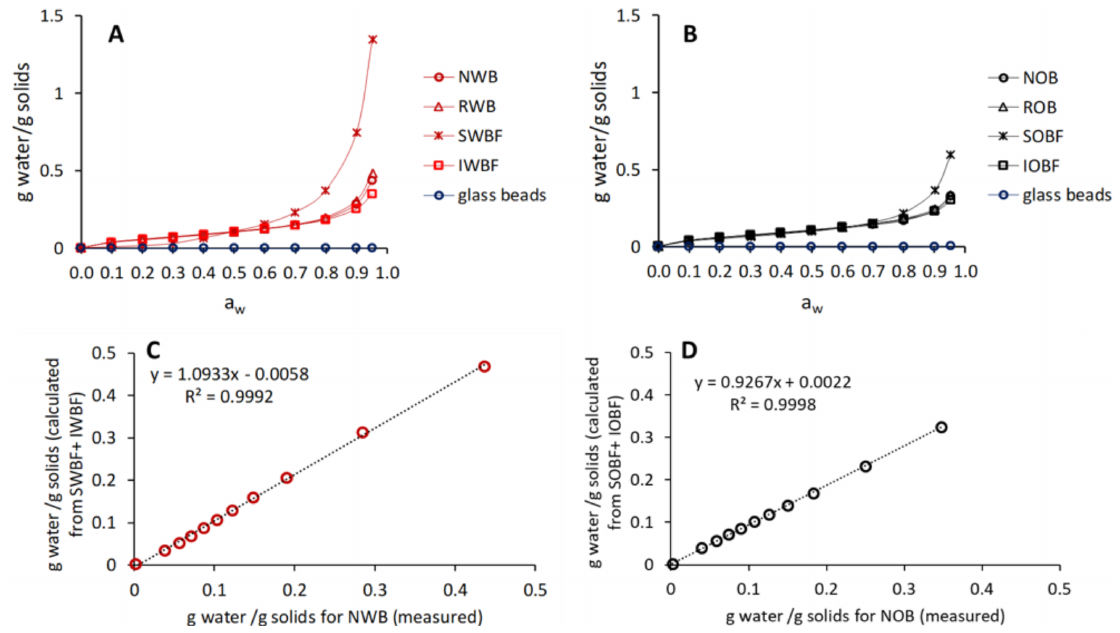
Figure 2. Moisture sorption behaviour of wheat bran ( A ) and oat bran ( B ) and their fractions as compared with glass beads. Moisture sorption computed from the isotherms of the soluble and insoluble bran fractions as compared with the native wheat ( C ) and oat ( D ) brans. Sample abbreviations are reported in Table